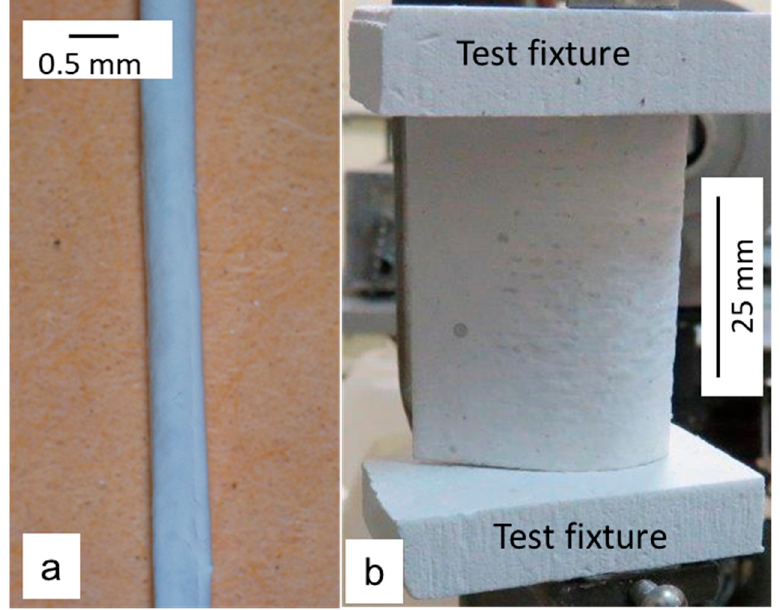
Figure 2. EBC-coated test pieces via spraying: ( a ) SiC/SiC mini-composite; ( b ) CMC airfoil—suction side.